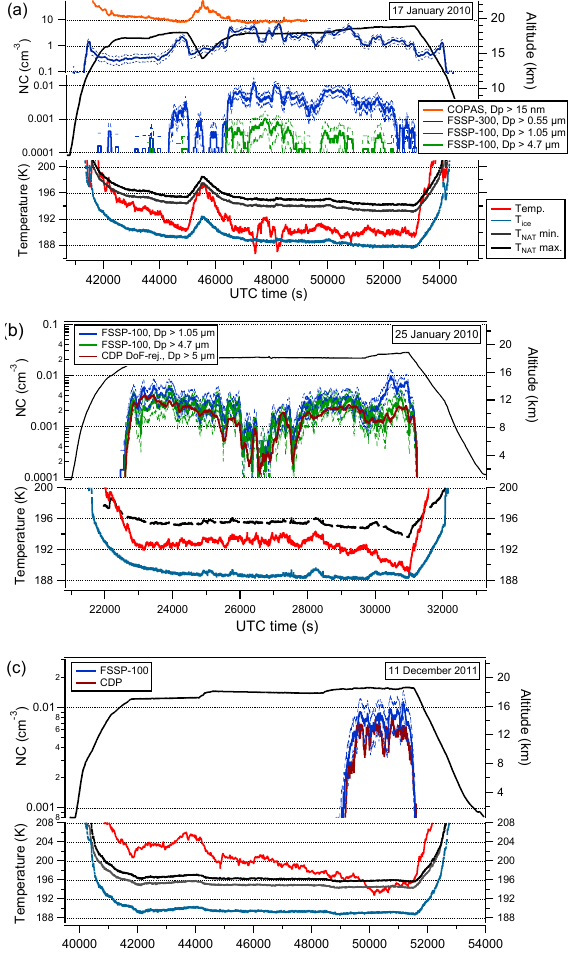
Figure 6. Time series of the FSSP number concentrations (NC) of two RECONCILE and one ESSenCe flights overlaid with rel- evant temperatures: ambient temperature (red), NAT equilibrium T NAT (black, gray) and frost point T ICE (blue). T NAT is estimated for 5 and 10ppbv of HNO 3 where no in situ NO y data are avail- able; otherwise in situ SIOUX-NO y data were used. (a) For the flight of 17 January 2010, FSSP-300-data are available and com- pared to the particle number concentration measured by COPAS, with a detection limit of 15nm. Here the synoptic scale of PSCs is apparent between 46000 and 53000UTCs. (b) RECONCILE flight on 25 January 2010. In this flight, the highest density of large (20–30µm) HNO 3 -containing particles of the campaign was en- countered. The number concentration derived from the counting of the DoF-rejected particles (dark-red curve) shows good agreement with the number concentration of the FSSP-100 for 4.7µm cutoff (green). Note that the curve deduced from the depth-of-field (DoF)- rejected events has much better counting statistics. (c) ESSenCe flight on 11 December 2011 with simultaneous measurement of the CDP and FSSP-100. Upper and lower dashed lines indicate the combined uncertainty due to the uncertainties of sample volume and counting statistics.